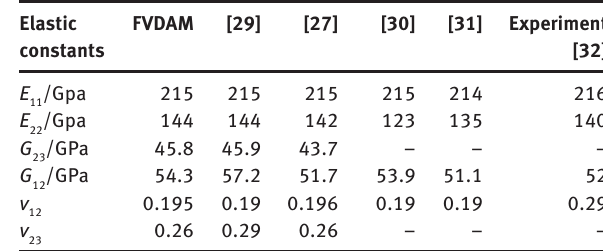
Table 1: Elastic modulus of boron/aluminum composites with volume fraction of